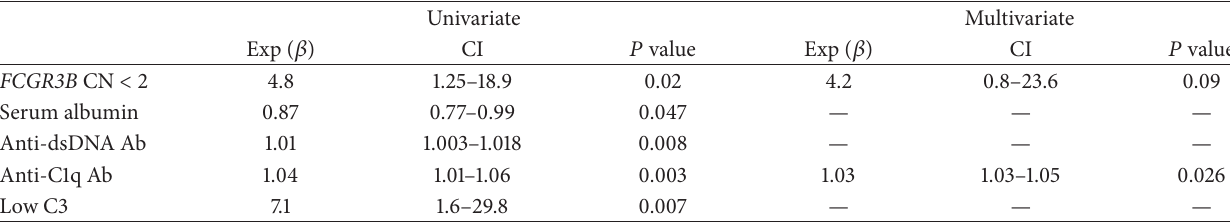
Table 3: Odds ratios (OR) for the association between disease characteristics and presence of LN. OR correspond to Exp ( 𝛽 ) in logistic regression analyses with presence of active LN as the dependent parameter (see methods for detailed description). “—” indicates nonsignificant findings upon multivariate